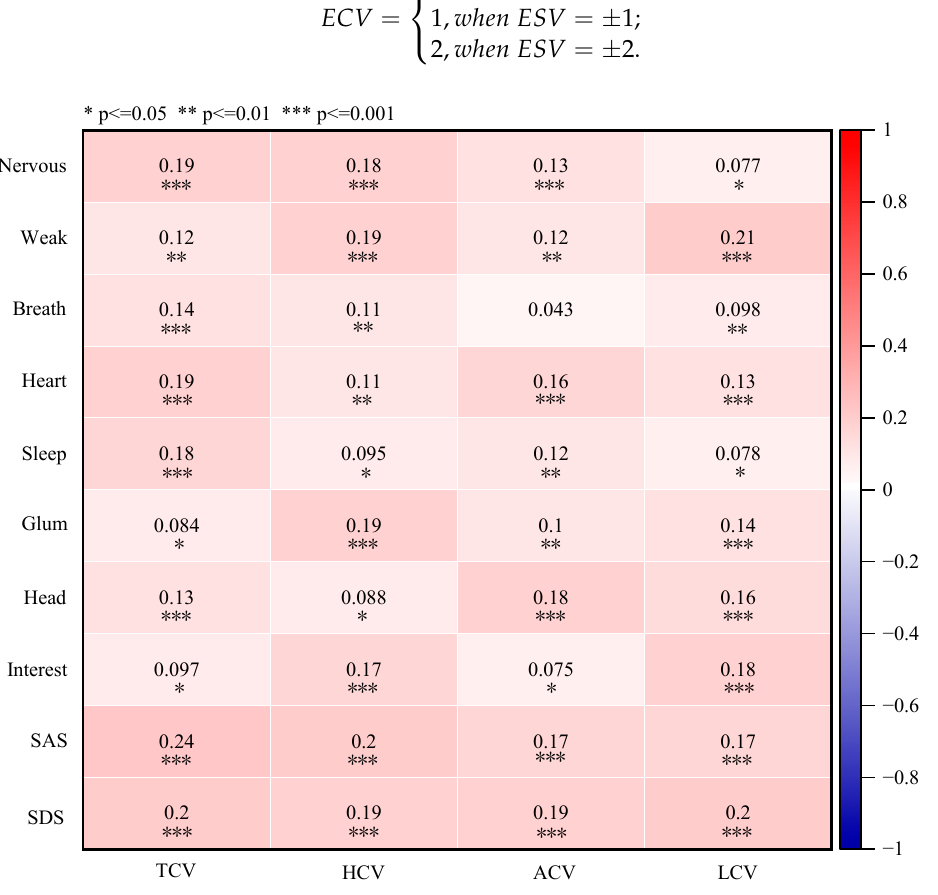
Figure 8. Results of the correlation analysis between environmental comfort and psychological state.